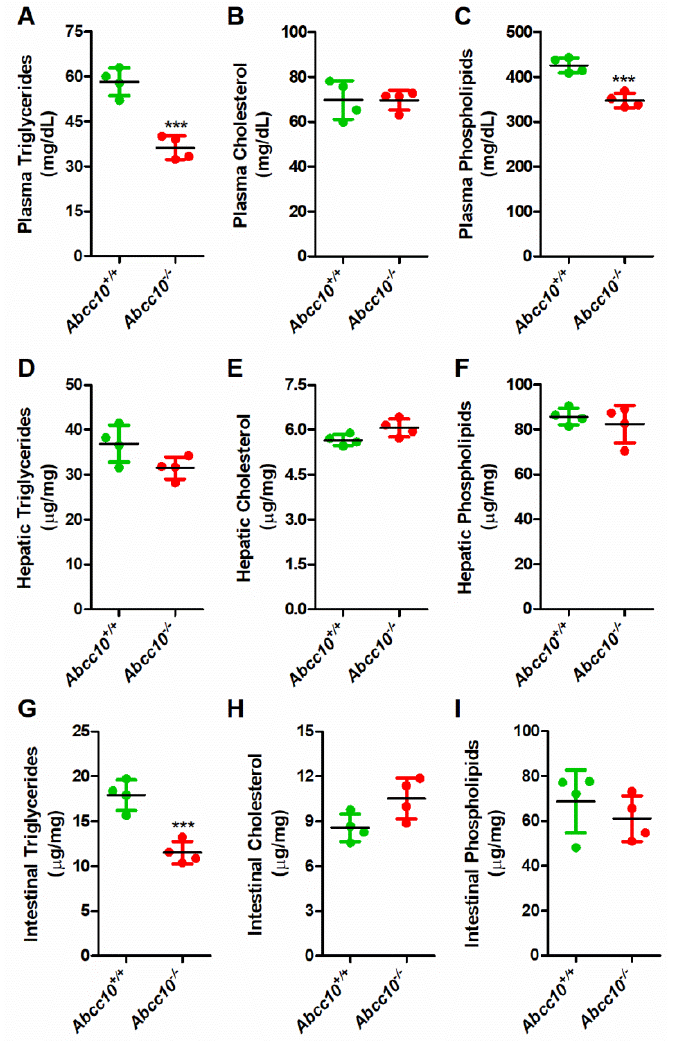
Figure 1. Deletion of Abcc10 gene in mice decreases plasma and tissue triglycerides. Chow-diet-fed, 12-week-old Abcc10 +/+ and Abcc10 − / − male mice ( n = 4) were fasted overnight and triglycerides ( A , D , G ), cholesterol ( B , E , H ), and phospholipids ( C , F , I ) were measured in plasma ( A – C ), liver ( D – F ), and intestine ( G – I ). Values are plotted as replicates (mean ± SD). *** p < 0.001, as compared with Abcc10 +/+ mice.